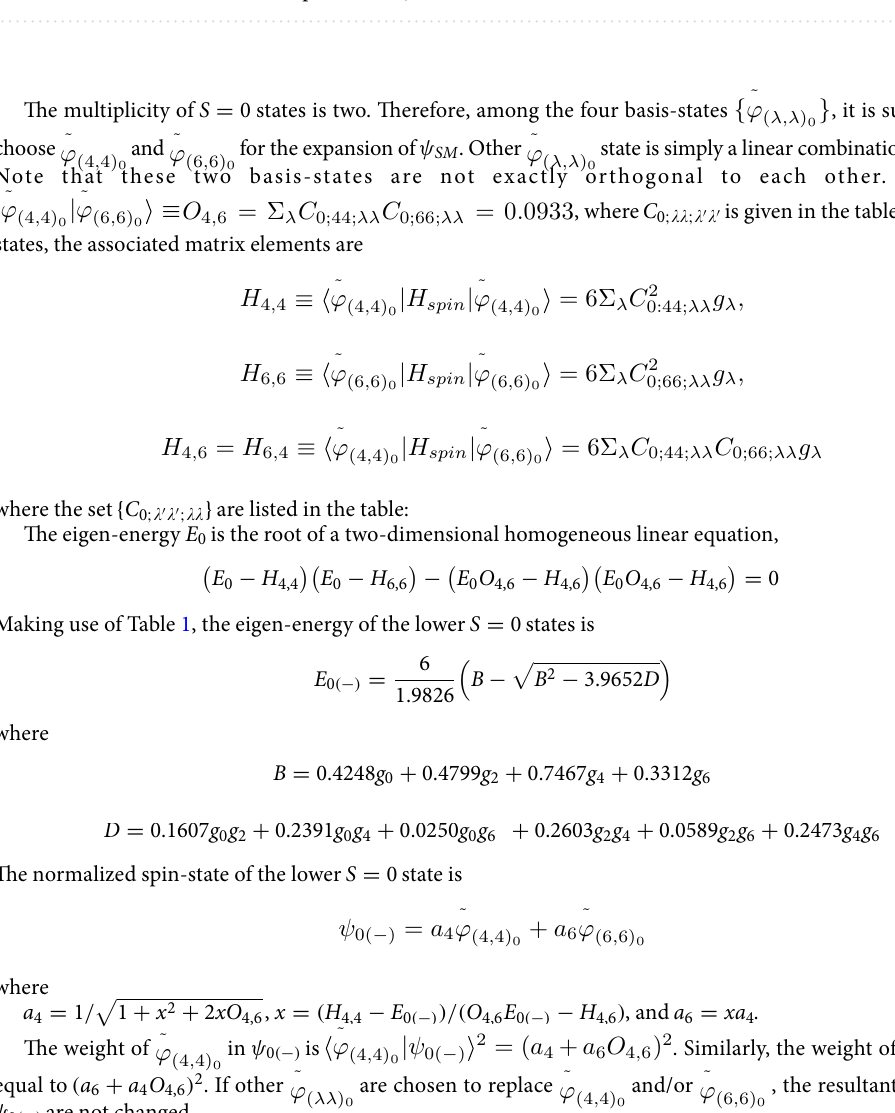
Table 1. The coefficients in the expansion of ψ SM when S =